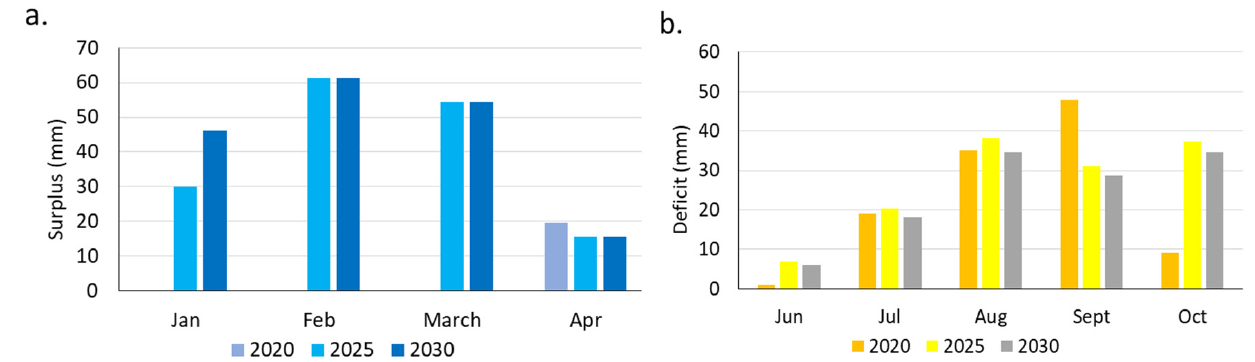
Figure 8. Changes in the water surplus ( a ) and deficit ( b ) in the years 2020, 2025, and 2030 based on the simulation with scenario one in the Dodokan Watershed.